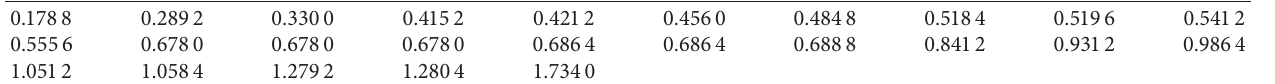
Table 5: The number of million revolutions before failure for ball bearings.